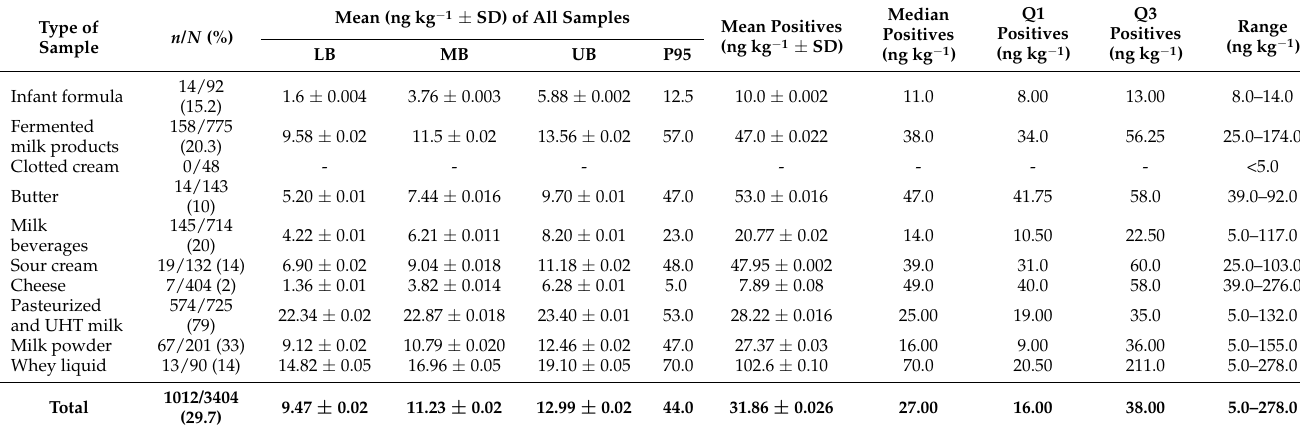
Table 1. Aflatoxin M1 incidence and concentration in milk and dairy product samples included in the study.